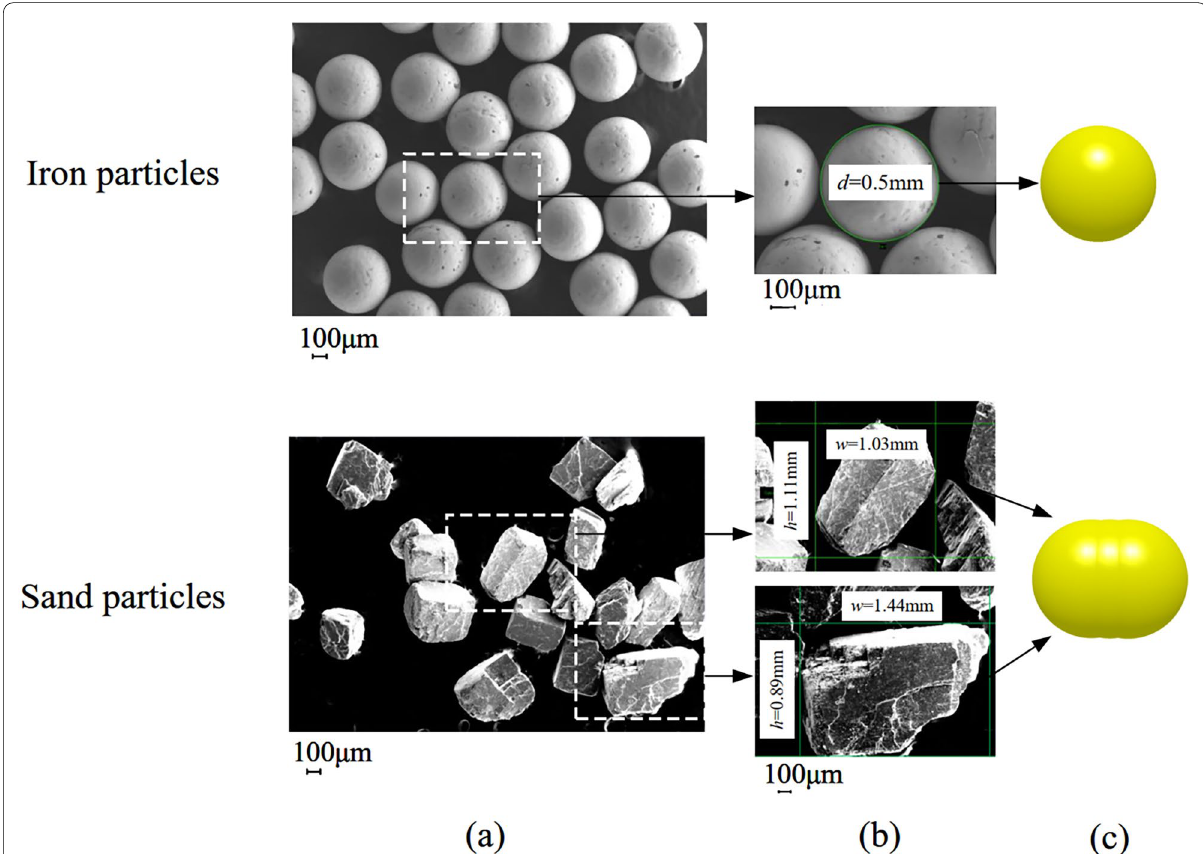
Figure 4 Particle SEM photographs and modeling: ( a ) Particle SEM photographs, ( b ) Particle details, ( c ) DEM